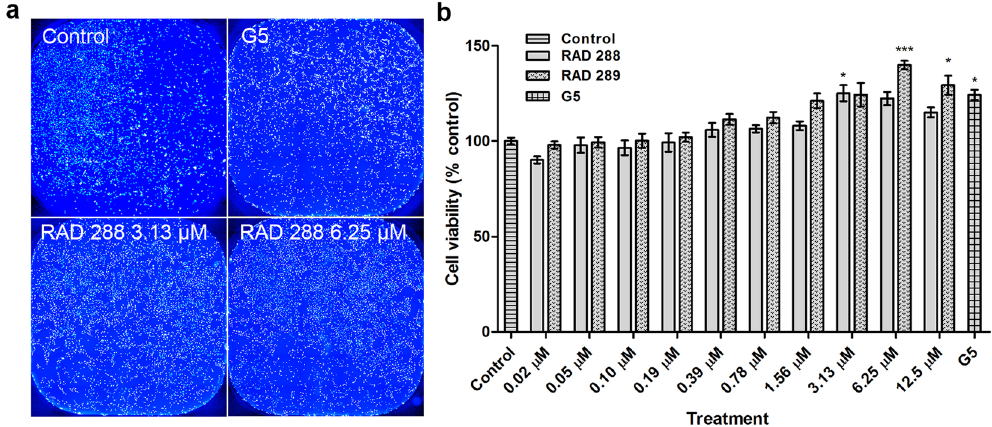
Figure 2. Effects on metabolic activity and proliferation of mOECs after treatments with RAD288 and RAD289. ( a ) Representative images of mOECs after drug exposure. Nuclei were stained with Hoechst. Scale bar = 100 µ m. ( b ) Cell viability of mOECs exposed to 0.2% dimethyl sulfoxide (control), 1% G5 Supplement, RAD288 (0.02–12.5 µ M) and RAD289 (0.02–12.5 µ M) using the resazurin metabolic activity indicator. Triplicate wells were used in three separate experiments, mean ± SEM. *** p < 0.001, * p < 0.05, Student’s t-test.